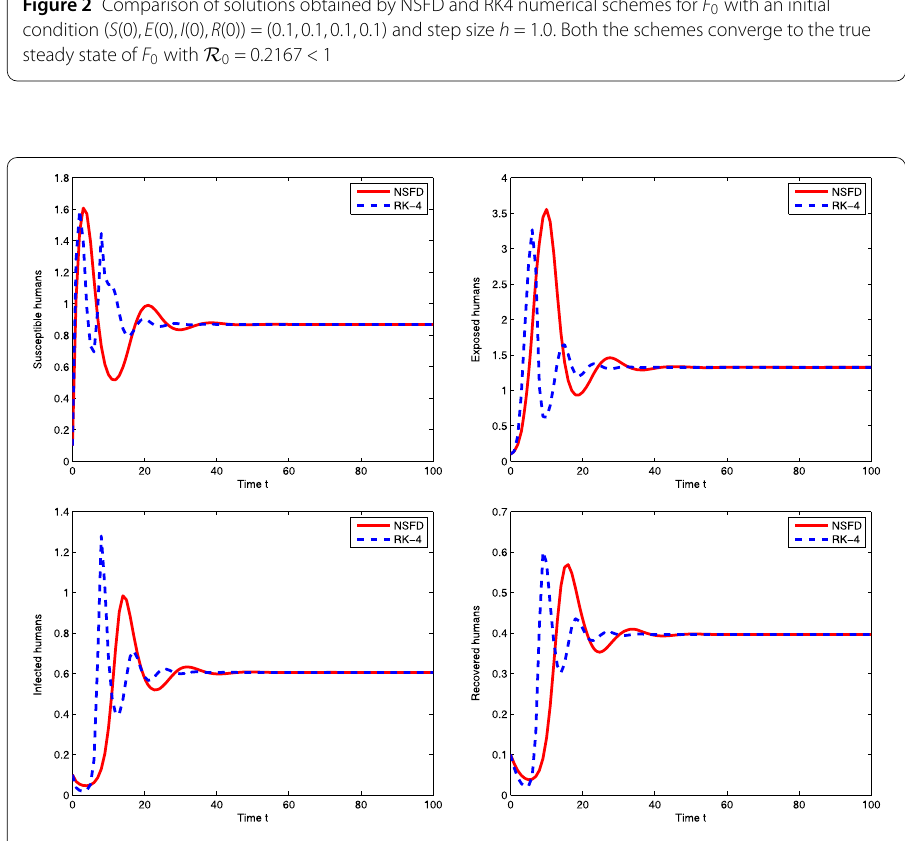
Figure 3 Comparison of solutions obtained by NSFD and RK4 numerical schemes for F 1 with an initial condition ( S (0), E (0), I (0), R (0)) = (0.1,0.1,0.1,0.1) and step size h = 1.0. Both the schemes converge to the true steady state of F 1 with R 0 = 7.0735 >